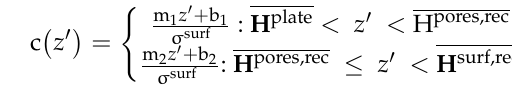
Figure 6. ( a ) Qualitative illustration of the linear sectional fit for the determination of the compression factor c. ( b ) Cross-sectional slice of the XCT data at a depth of 3.5 mm. The height deviations corresponding to the manufacturing layers calculated from g x’,y’ ( z’ ) are depicted as blue lines. The compression factor c is given